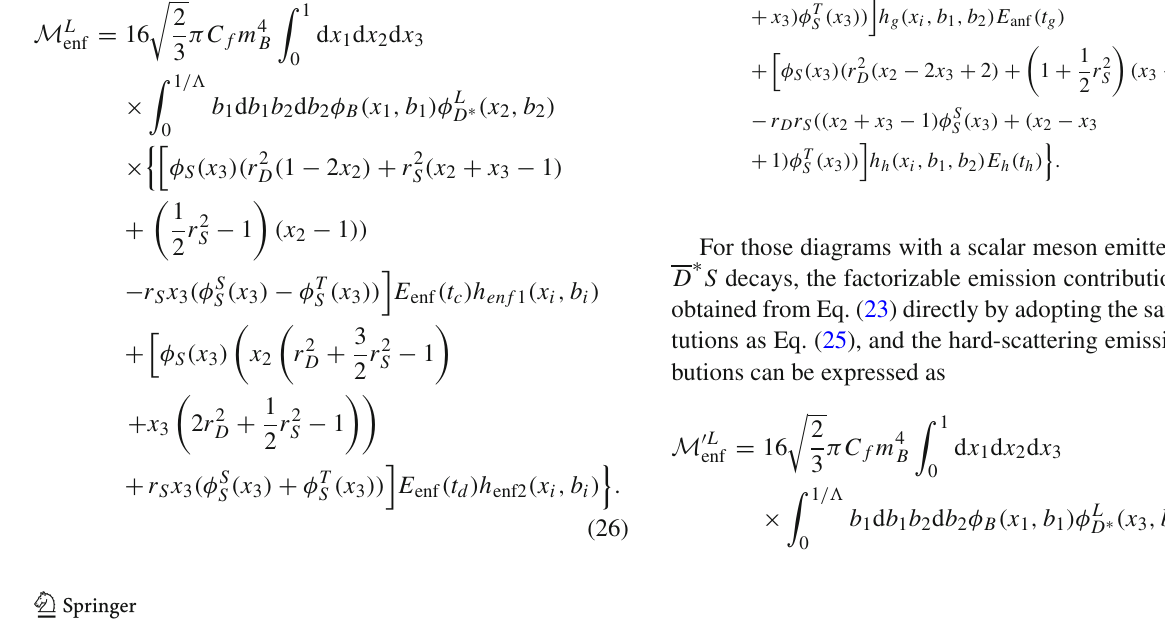
( t (cid:5) ) h (cid:5) c